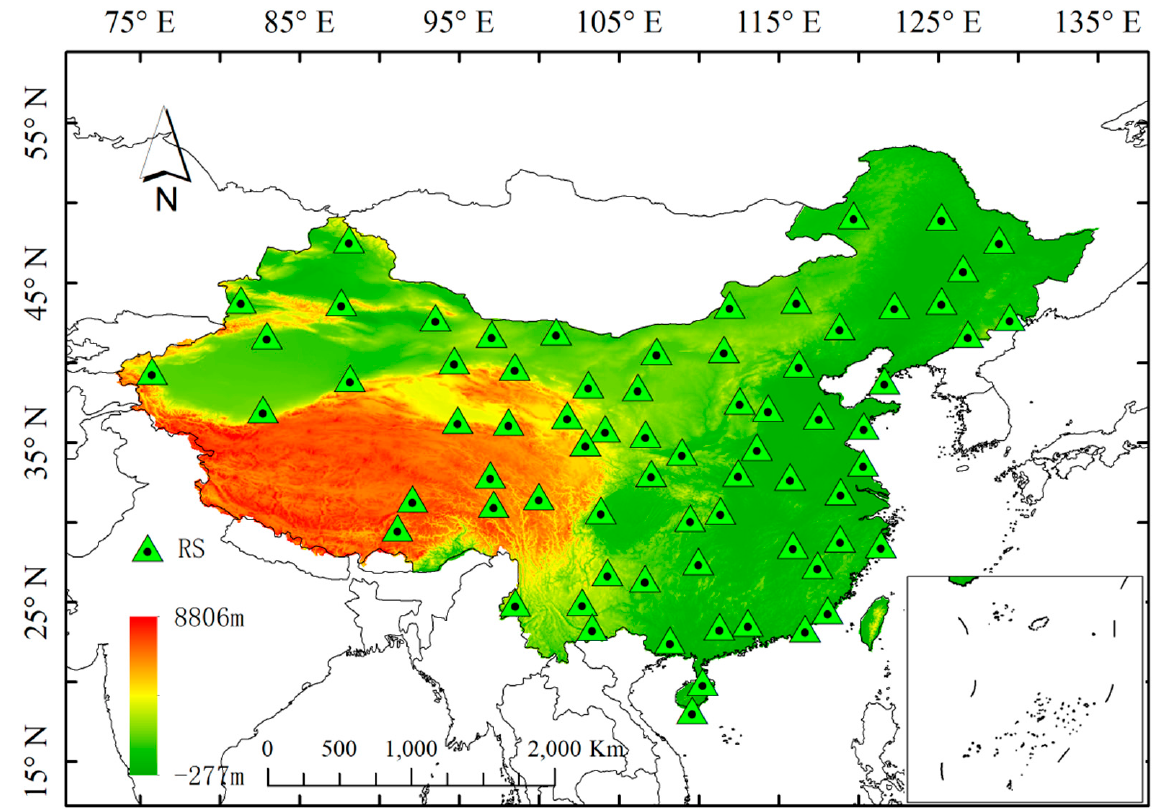
Figure 1. The distribution of the study area and the radiosonde stations (RS) used for modeling.